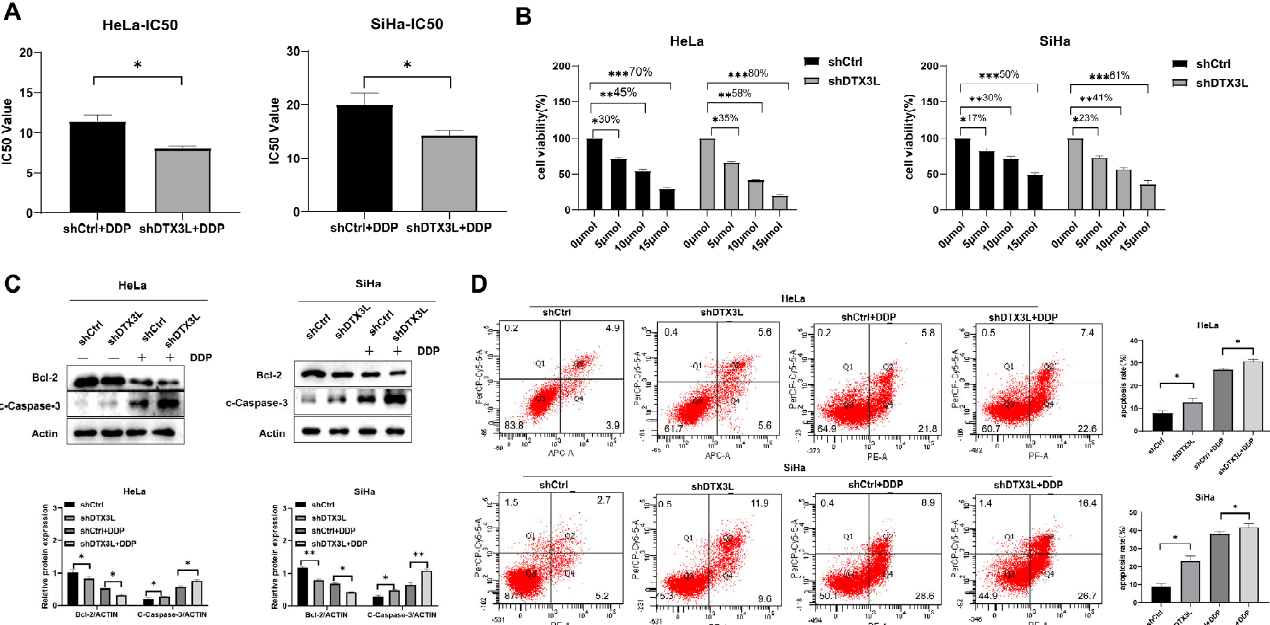
Figure 6. Combination of silencing DTX3L and cisplatin treatment enhanced apoptosis of CC cells ( A ) IC50 values to cisplatin of shDTX3L and shCtrl cells were analyzed by a CCK-8 assay. The used cisplatin concentrations were as follows: 0, 2, 4, 8, 16, 32 and 64 µ mol/mL. ( B ) shDTX3L and shCtrl cells were treated with different concentrations of cisplatin. Cell viability was determined by a CCK-8 assay 24 h after treatment. ( C , D ) shDTX3L and shCtrl cells were treated with or without cisplatin for 24 h. Protein expression levels of Bcl-2 and c-Casepased-3 were measured by Western blot analysis. Apoptosis ability was detected by flow cytometry, and the percentages of early apoptotic (PE-A+/7-AAD − ) and late apoptotic (PE-A+/7-AAD − ) cells were combined for analysis. * p < 0.05; ** p < 0.01; *** p <